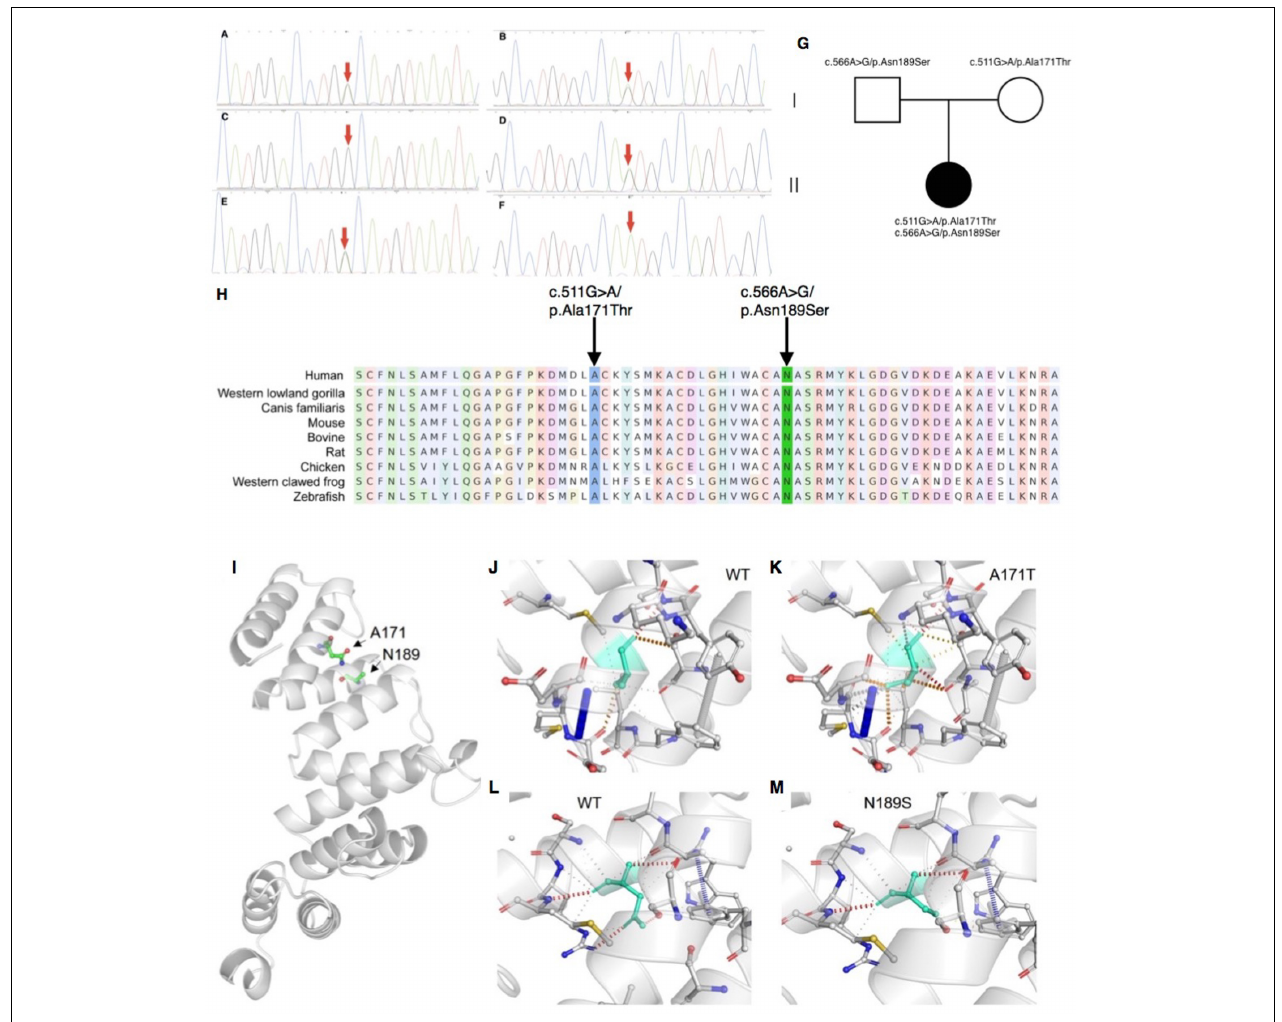
FIGURE 2 | Sanger sequencing, conservation analysis and homology modeling. (A–G) Sanger sequencing and pedigree showing the segregation of the variants in the family. (A,B) The patient carries the c.511G > A/p.Ala171Thr and c.566A > G/p.Asn189Ser mutations. (C,D) The patient’s father carries the c.566A > G/p.Asn189Ser but not c.511G > A/p.Ala171Thr mutation. (E,F) The patient’s mother carries the c.511G > A/p.Ala171Thr but not c.566A > G/p.Asn189Ser mutation. (G) Segregation of variants within the family. (H) Conservation analysis showing both sites of the missense mutations were conservative among different species. (I–M) The impact of COA7 missense mutations on protein structure. (I) COA7 as a ribbon representation; residues A171 and N189 are drawn with a ball-and-stick representation. (J,K) Detailed view of the environments of A171, A171T, N189 and N189S where the residues are colored in light-green and represented as sticks, possible interactions between neighbor atoms are indicated with dashed lines, dark red for hydrogen bonds, green for hydrophobic contacts, and deep plink for carbonyl contacts.